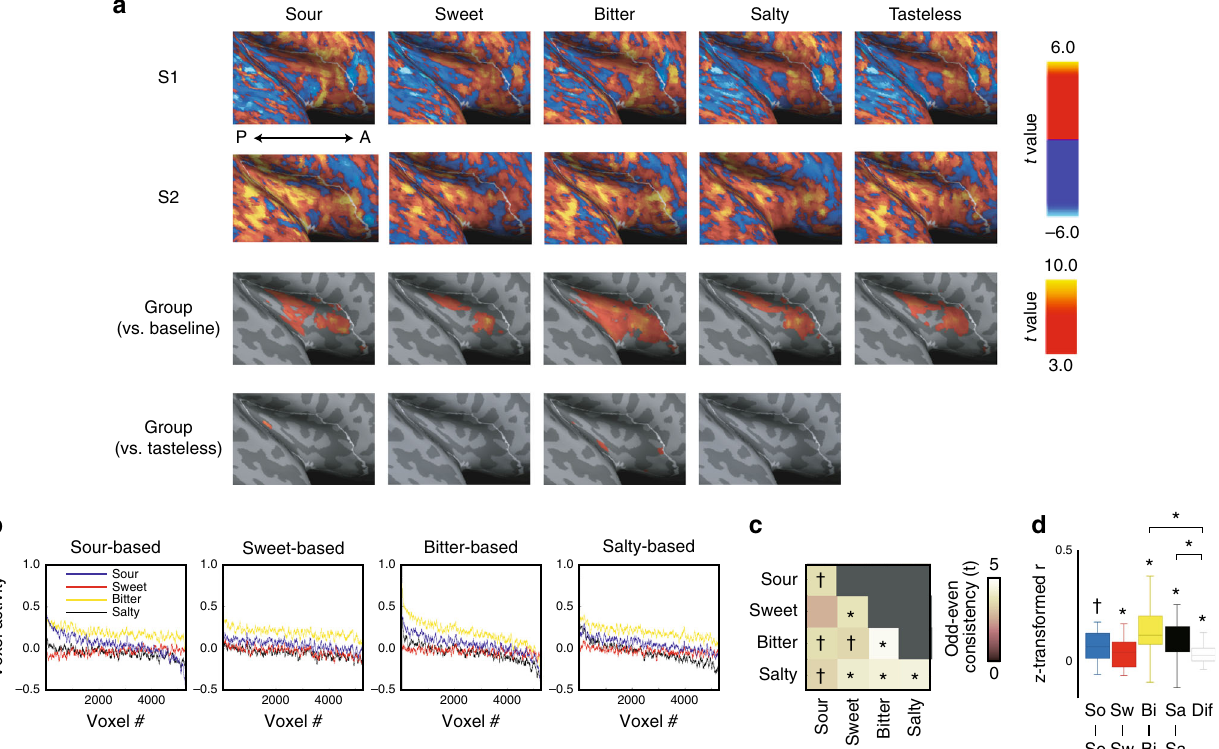
Fig. 1 Univariate analysis of voxel-speci fi c taste tuning in the insula. a Upper two rows indicate activation maps for sour, sweet, bitter, salty, and tasteless stimuli of two subjects S1 and S2. The third row indicates group results when contrasted against baseline fMRI activity ( n = 20 participants). The fourth row indicates group results when contrasted against tasteless, to control for non-taste-related gustatory activity and swallowing. When estimated against tasteless, controlling for positive and negative hedonic values, no taste-sensitive voxels survived statistical signi fi cance. A: anterior, P: posterior. b Each participant ’ s voxel activity in odd runs were aligned based on rank-ordered sensitivity to each sour, sweet, bitter, and salty taste in even runs, then averaged across participants. The corresponding downward trend for all tastes in each panel shows a lack of taste speci fi city. c Correlations were computed for voxel activation between odd and even runs between all taste combinations within each participant, submitted to one-sample t -test across participants. Corresponding activation between taste types shows a lack of taste-speci fi c voxel tuning in the insula. d Correlations between odd and even runs for all same taste and different taste combinations within each participant. Correlation coef fi cients were z -transformed and subject to one-sample t -test across participants. Boxes represent the median and 25th/75th percentiles and whiskers represent the minimum and maximum. Bi: bitter, Dif: different, Sa: salty, So: sour, Sw: sweet. ✝ p < 0.05 uncorrected, * p < 0.05 after Bonferroni correction for multiple comparisons (FWE <